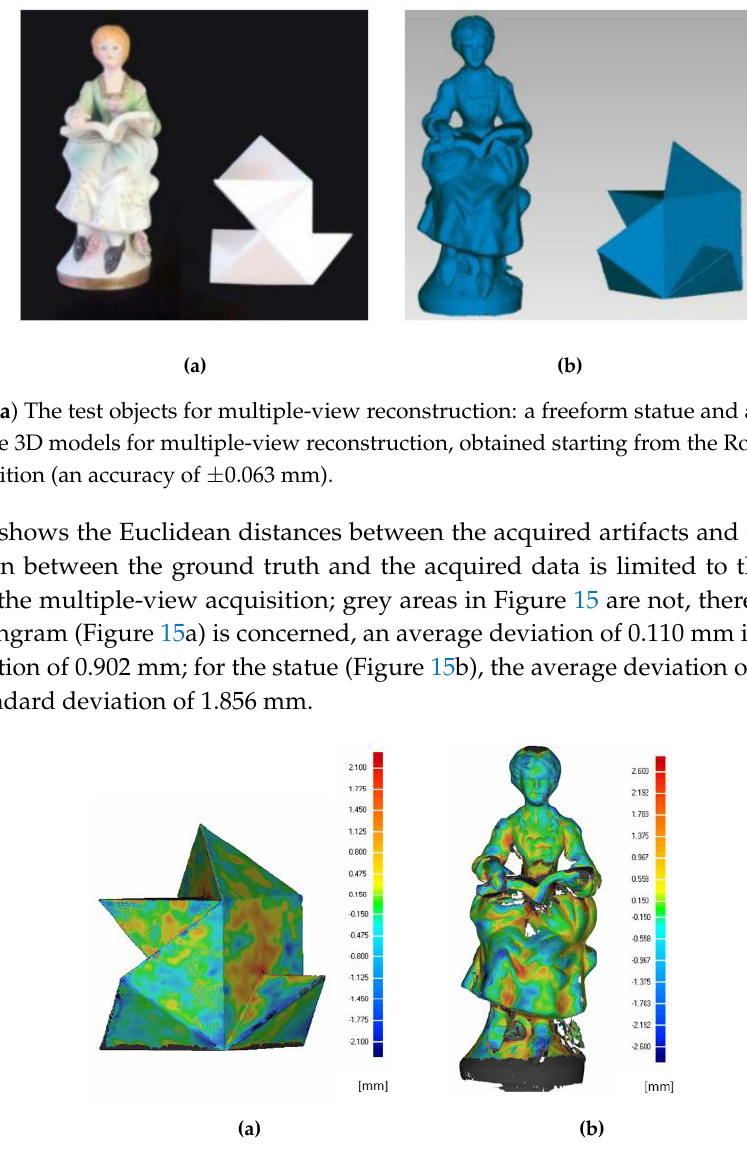
Figure 15. ( a ) The 3D comparison between the tangram ground truth and the D415 acquired data. Errors are in mm. ( b ) The 3D comparison between the statue ground truth and the D415 acquired data. Errors are in